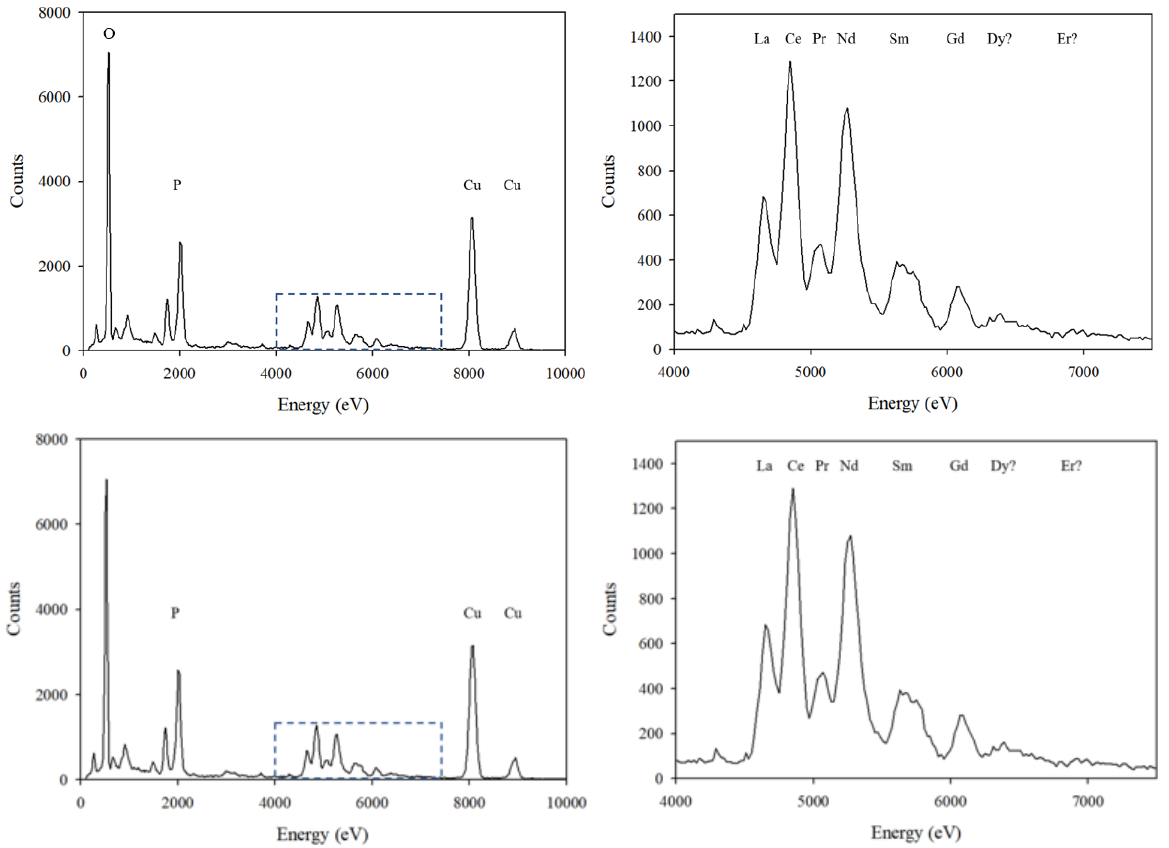
Figure 13. EDS for area 3 within area 0940. The full counts for the 0 to 10,000 eV range are shown on the left and a restricted count range for the 4000–7500 eV range is shown on right (dashed box on full-range figure indicates the area of the right figure). The Dy and Er “peaks” do not represent significant concentrations of those elements. The Cu peak belongs to the grid holder, not the sample.